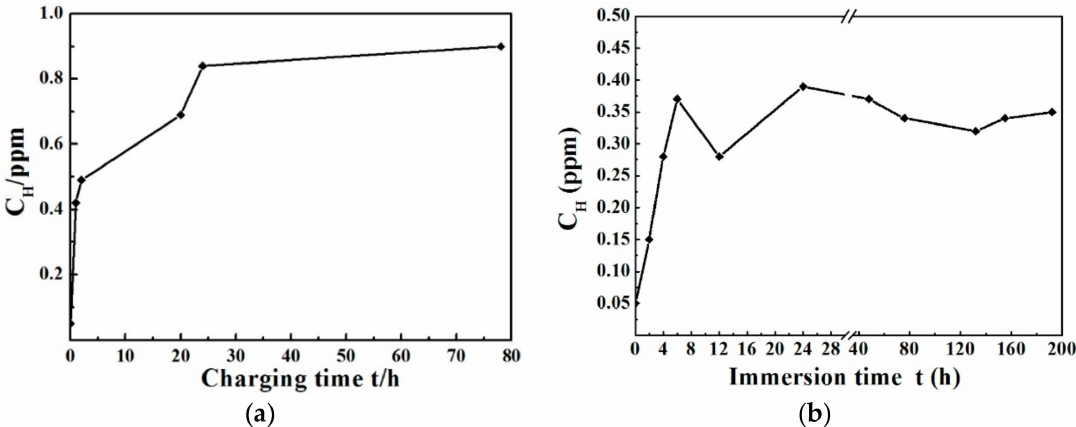
Figure 5. The evolution of hydrogen content with respect to ( a ) charging time and ( b ) immersion